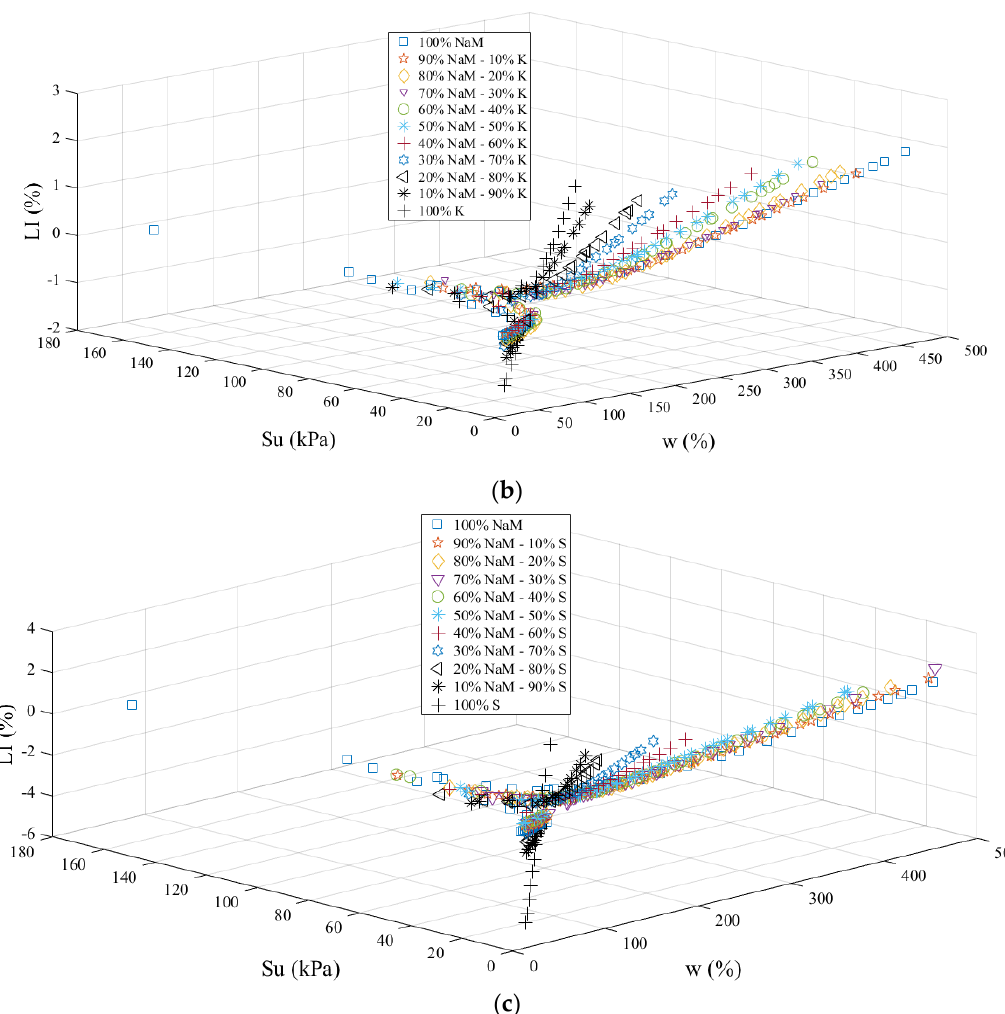
Figure 5 . Relationship among undrained shear strength, water content and liquidity index for ( a ) NaM – CaM , ( b ) NaM – K and ( c ) NaM – S mixtures.